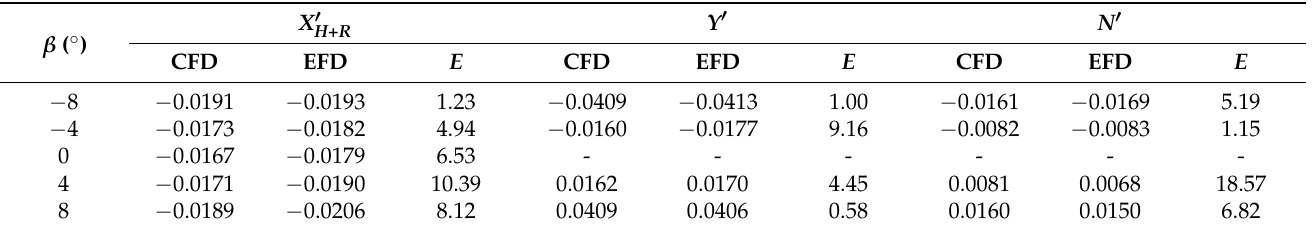
Table 15. The error between the CFD computed results and EFD data for water–air flow simulation, Fr =